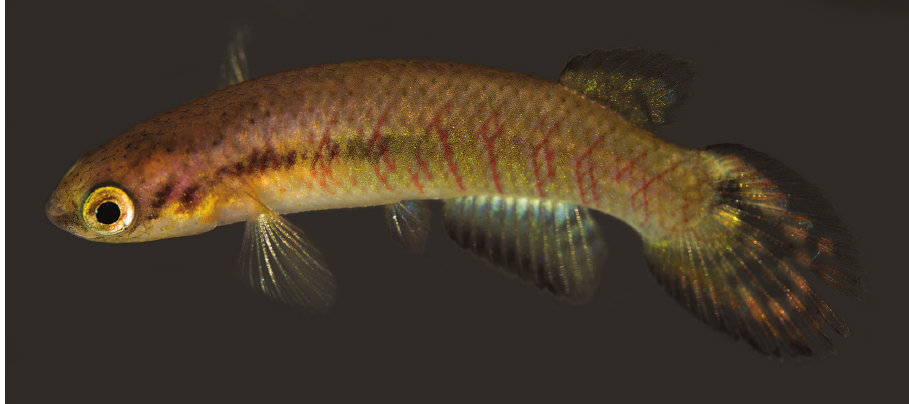
Figure 8. Melanorivulus dapazi , UFRJ 11203, female, 22.2 mm SL. Photograph by W.J.E.M. Costa. fin. In addition, in both species the spot on the basal portion of the female caudal fin is inconspicuous in live fish (Figs 2 and 5) and poorly visible in preserved